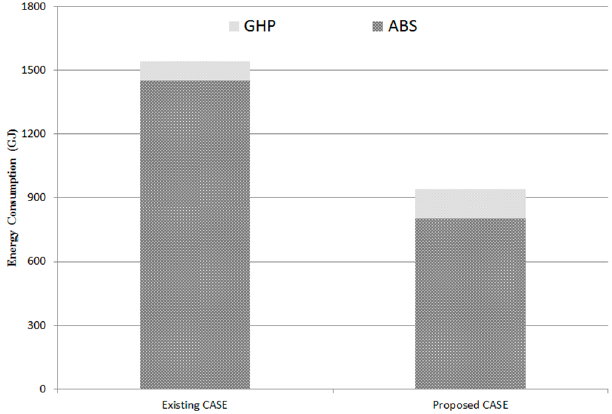
Figure 13. Energy consumption of each GHP in hybrid GHP Operation Method.